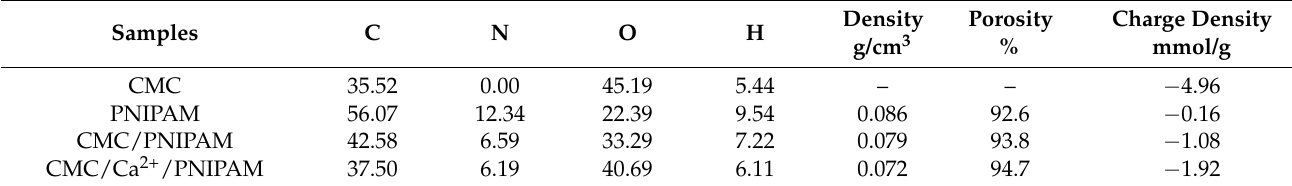
Table 1. Properties of CMC and